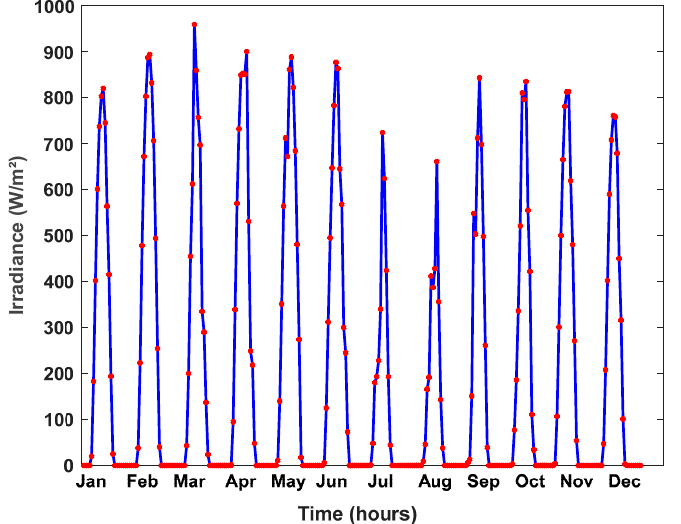
Figure 3. Monthly hourly irradiance of Salak.